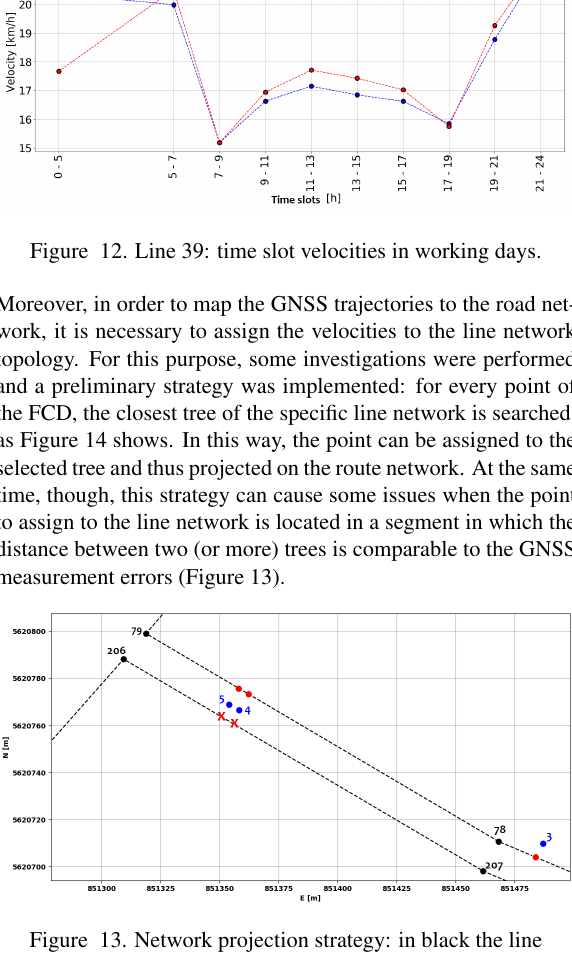
Figure 9. Line 11: time slot velocities in weekend days.